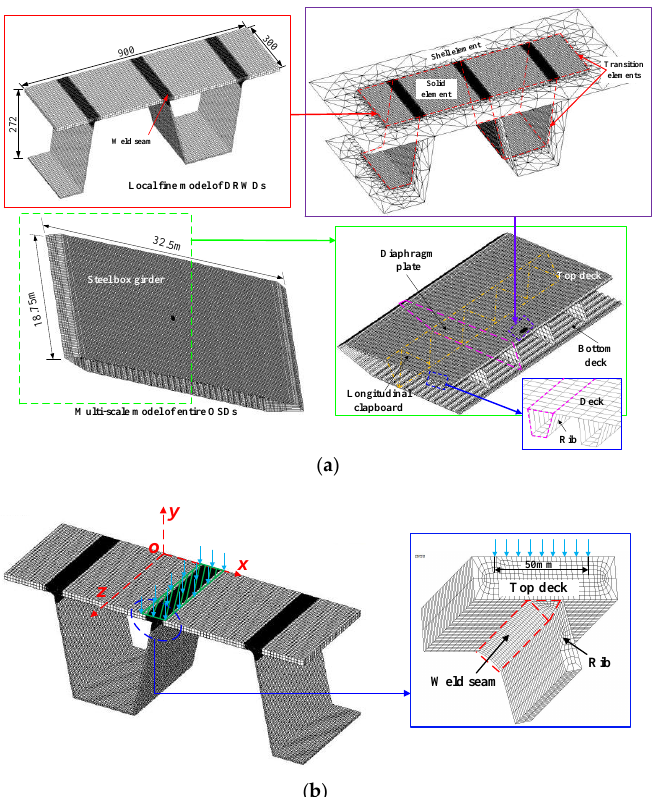
Figure 10. A multi-scale coupled stress analysis model: ( a ) build model; ( b ) load model (unit: mm).